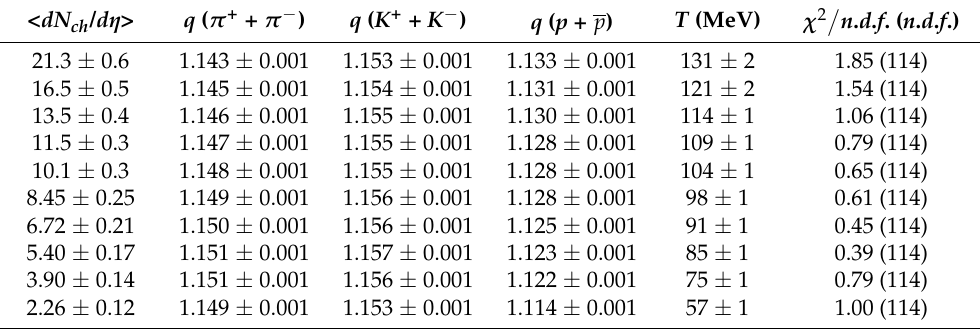
Table 2. Parameters obtained using combined minimum χ 2 fits with the Tsallis function with thermodynamical consistence (Equation (6)) of p t spectra of particles in various groups of < dN ch / d η > in proton-proton collisions at ( s ) 1/2 = 7 TeV. The fitted p t ranges are [0.5–20.0] GeV/ c for π + + π − , [0.2–20.0] GeV/ c for K + + K − , and [0.3–20.0] GeV/ c for p + p . Here, n.d.f. denotes the number of degrees of freedom.